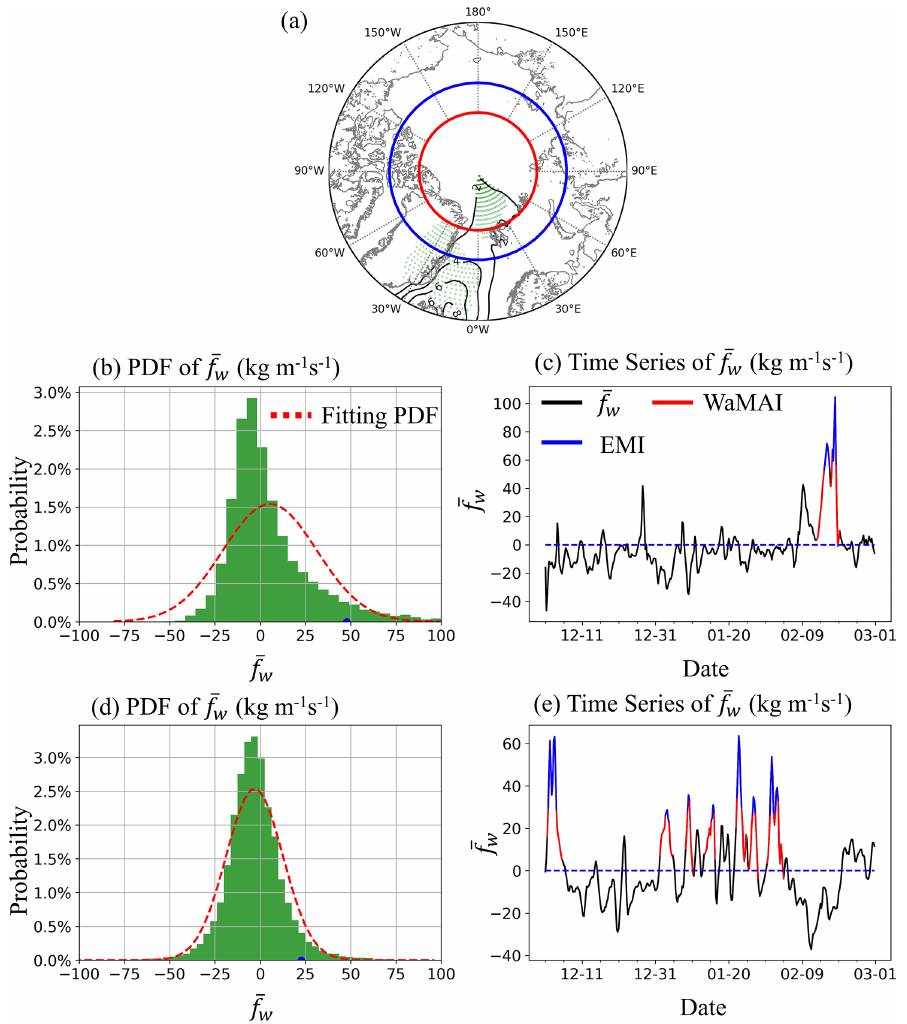
Figure 2. (a) Contours of the linear regression between local f w and normalized SIC anomalies (multiplied by − 1), defined as the anomaly divided by its standard deviation, for the winter months (DJF) over the Barents Sea. The stippling indicates statistical significance at the p < 0 . 05 level for the Student’s t test. Note that the linear regression is calculated against standardized sea-ice concentration. Therefore, its unit is same as the unit of f w and the value represents the general variation of f w from the climate mean during the sea-ice retreat. Red line is the latitude of 80 ◦ N where the trajectories over the Barents Sea are launched, while blue line is the latitude of 75 ◦ N where the trajectories are launched over the sea sectors of Kara Sea, Laptev Sea, East Siberian Sea, Chukchi Sea, and Beaufort Sea; panels (b) and (d) show the probability distribution function of f w over the Barents Sea and Beaufort Sea, respectively, with the 95th percentile marked as a blue dashed line; panels (c) and (e) are the time series of f w over the Barents Sea and Beaufort Sea in 1980, respectively, with WaMAI highlighted in red and EMIs highlighted in